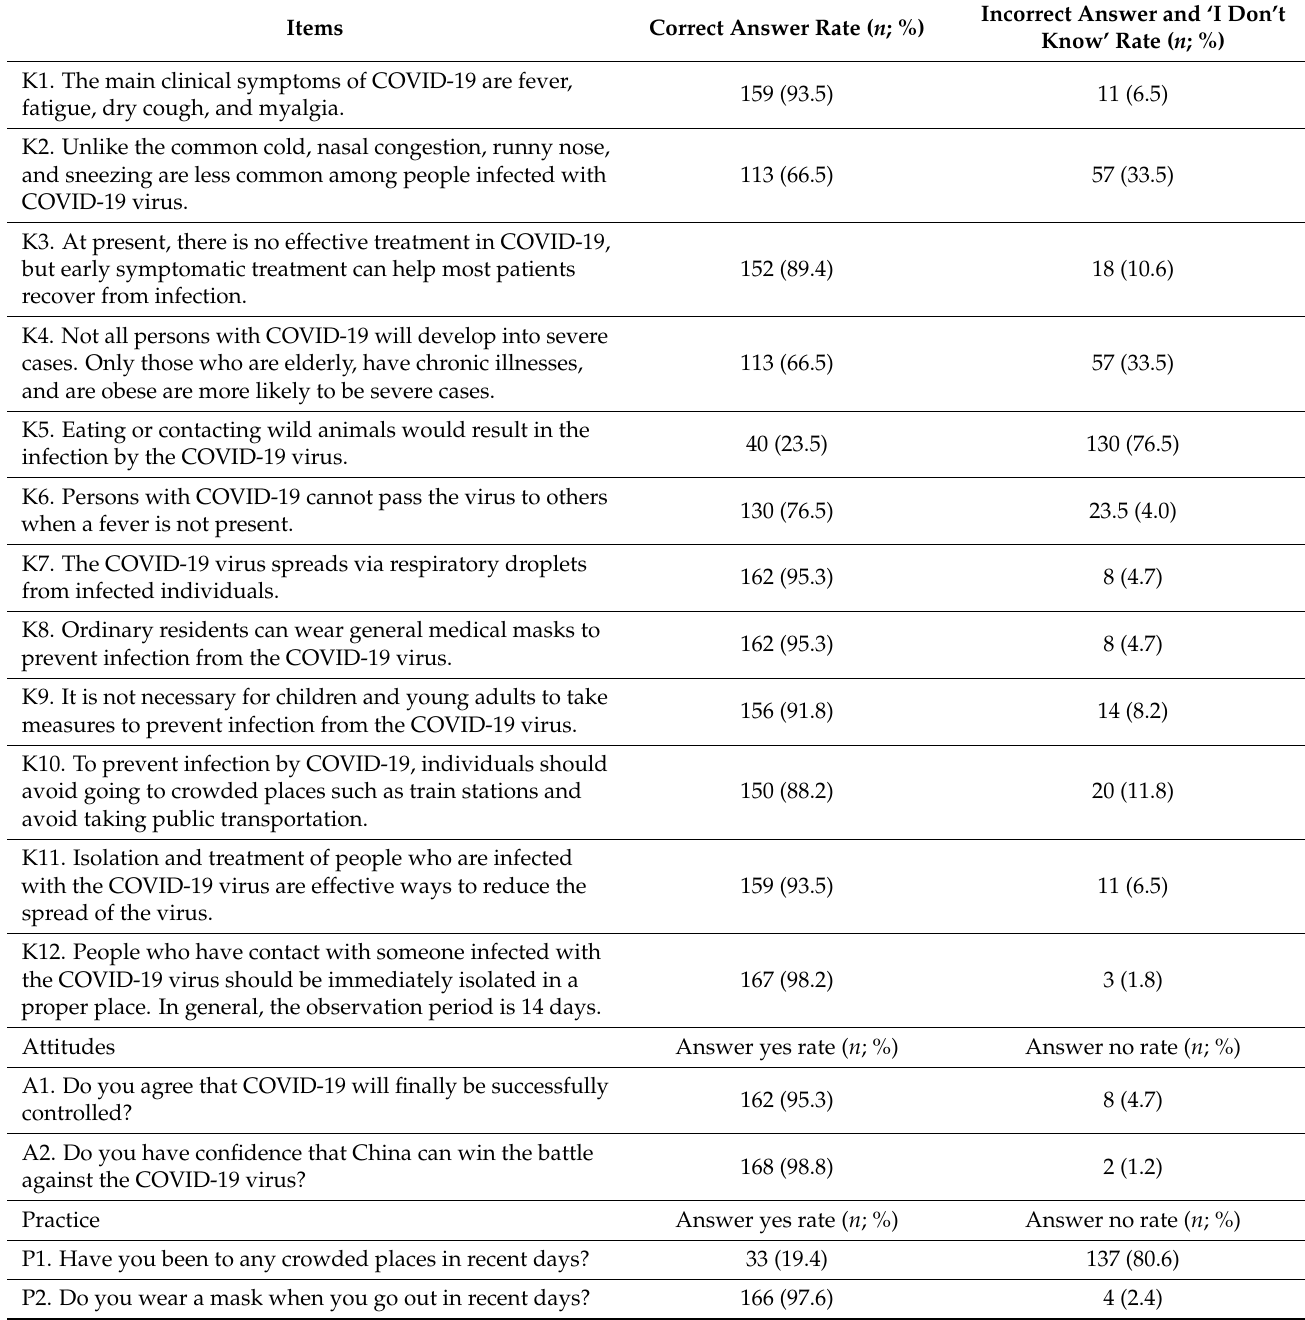
Table 1. Responses to the questionnaire on COVID-19